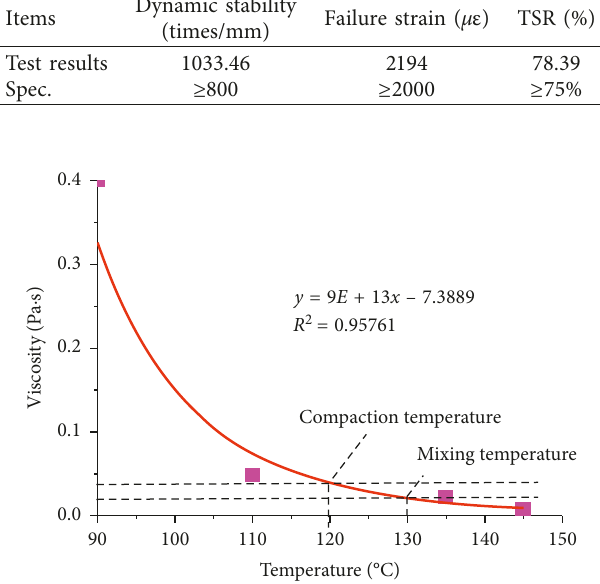
Figure 1: Viscosity-temperature curve of the control mix